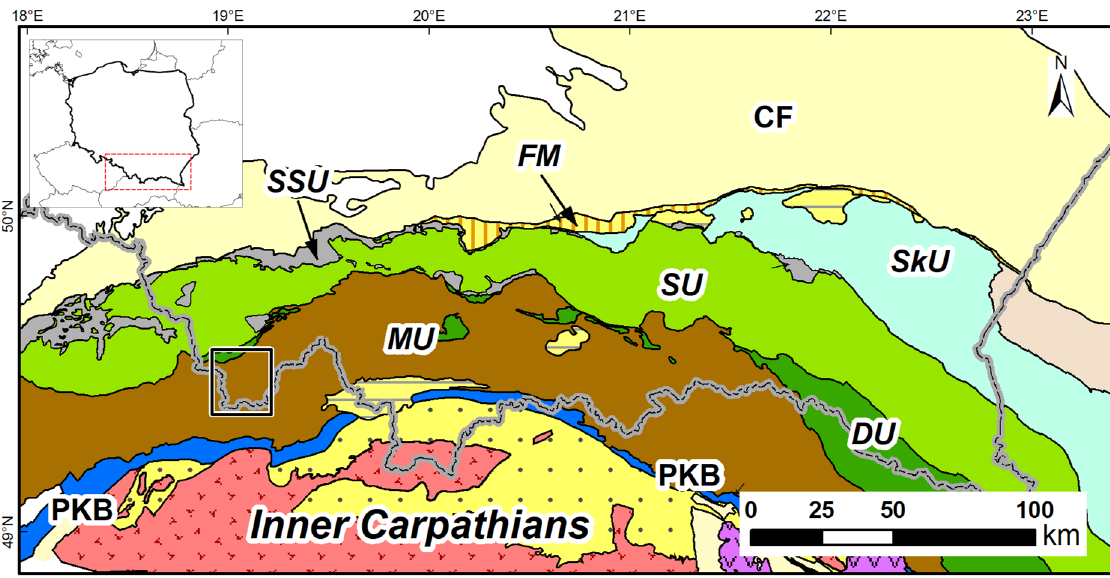
Figure 1. Schematic map of the Polish Outer Carpathians. Research area marked with a black rectangle (see Figure 3). PKB—Pieniny Klippen Belt (tectonic suture zone between the Outer and Central Western Carpathians of thrust and strike-slip origin, represented by the Jurassic-Lower Cretaceous shallow to deep-water limestones), MU—Magura Unit (the innermost and largest tectonic unit of the Western Outer Carpathians, built of the Upper Cretaceous and Paleogene flysch-type sediments), DU—Dukla Unit (structurally lower unit, composed of the Upper Cretaceous and Paleogene pre- and synorogenic flysch-type sediments), SU—Silesian Unit (composed of continuous succession of the Upper Jurassic to Lower Miocene deposits, with predominance of pre-orogenic flysch deposits in the western part and syn-orogenic in the east), SSU—Sub-Silesian Unit (tectonically underlying the Silesian Nappe, composed mostly of the Upper Cretaceous to Eocene pelagic variegated marls, deposited on the intrabasinal Sub-Silesian ridge forming the northern slope of the Silesian Basin), SkU—Skole Unit (most external unit of the Polish Outer Carpathians, built of the Lower Cretaceous to Miocene rock succession with predominance of syn-orogenic Oligocene to Miocene deposits), CF—Carpathian Foredeep (molasses-type sediments), FM—Folded Miocene sediments of Carpathian Foredeep (para-autochthonous). See text for more explanations.